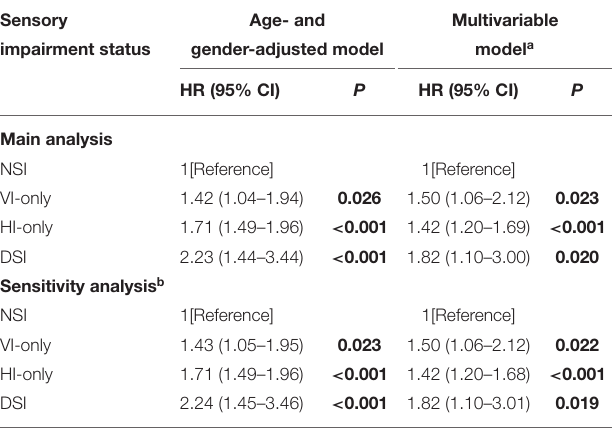
TABLE 3 | Association of sensory impairment status with incident dementia. Sensory Age- and